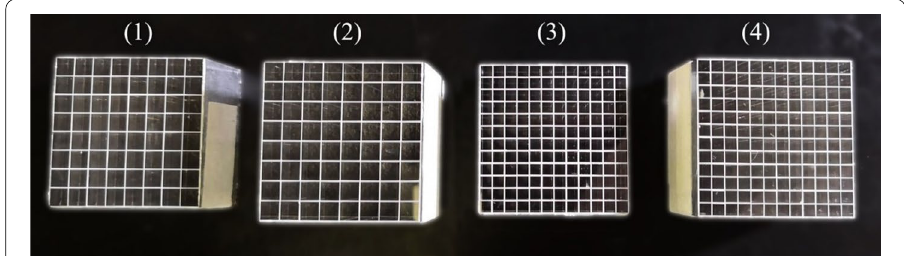
Fig. 1 Photo of the four LYSO crystal arrays evaluated in this work, the crystal sizes of the four arrays being (1)